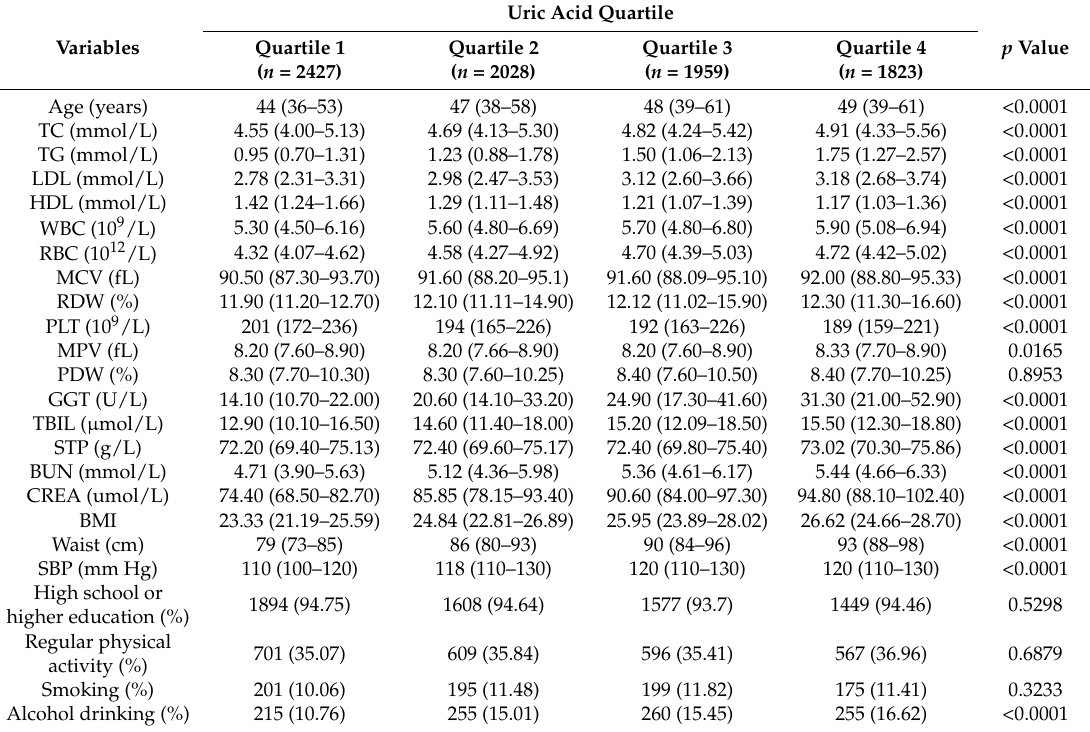
Table 1. Distribution of potential confounding factors of participants grouped by serum uric acid (SUA) quartiles status at